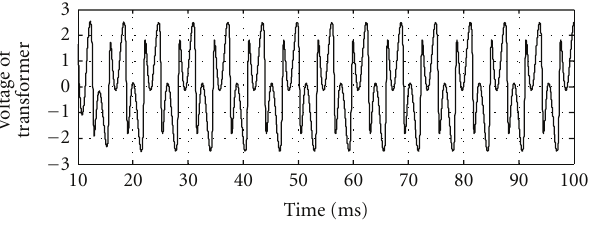
Figure 2: Time domain simulation for q = 7 (ZnO e ff ect).